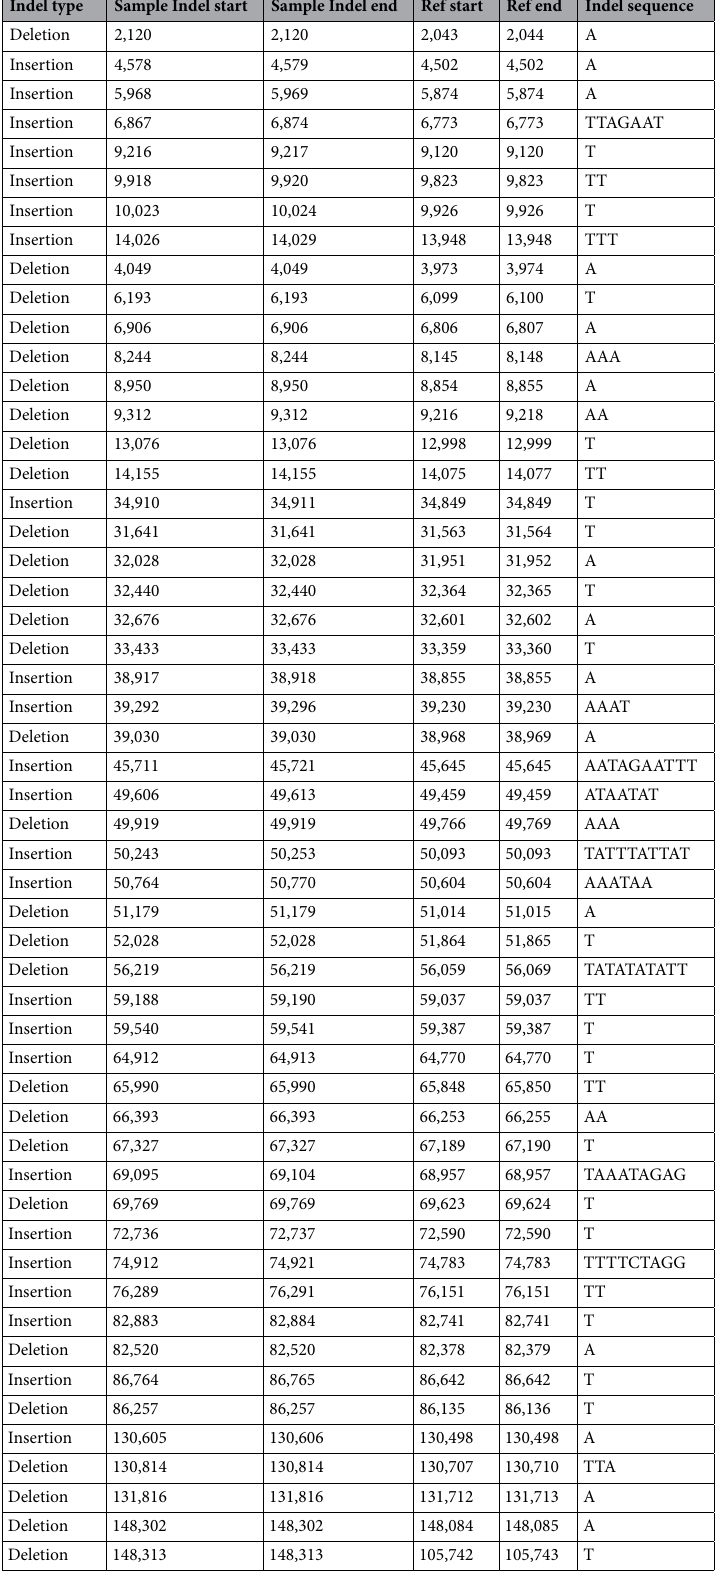
Table 4. Indel statistics between P3B and